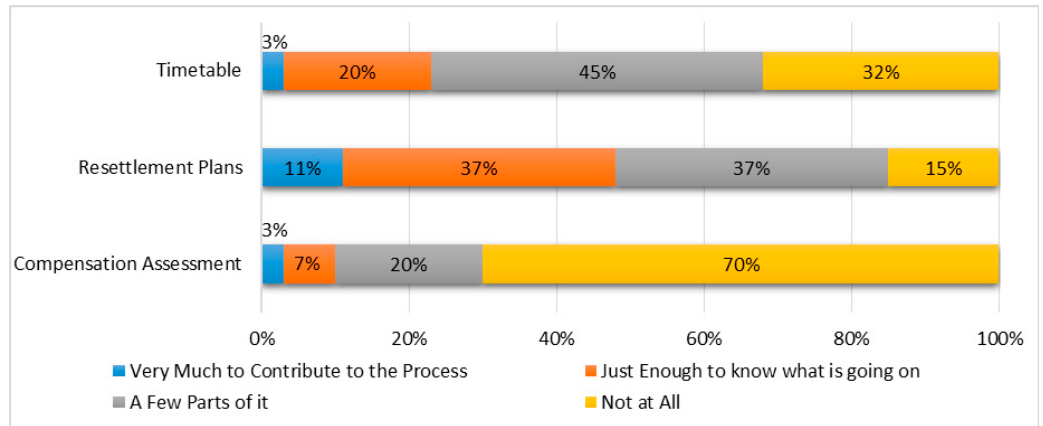
Figure 4. How clear were the explanations of these aspects of the compulsory land acquisition and resettlement process? (n = 38).